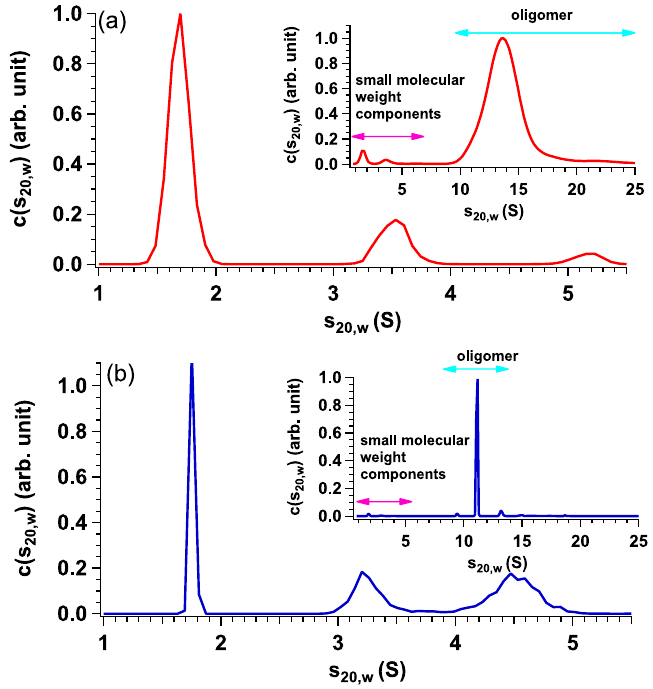
Figure 3. AUC spectra of dilute and dense samples. ( a ) c ( s 20,w ) from αB-crystallin in solution at 0.45 mg/mL measured at 60,000 rpm at 37 °C. The M w s of three peaks correspond to 19 kDa, 56 kDa and 101 kDa from the low c ( s 20,w ) to the high one, respectively. The inset shows c ( s 20,w ) from αB-crystallin in the solution at 0.45 mg/ mL measured at 40,000 rpm at 37 °C. The pink and light blue arrows indicate the region corresponding to small molecular weight components and oligomers, respectively. ( b ) c ( s 20,w ) from αB-crystallin in solution at 28.5 mg/ mL measured at 60,000 rpm at 37 °C. M w s of three peaks correspond to 21 kDa, 53 kDa, and 87 kDa from the low c ( s 20,w ) to the high one, respectively. The inset shows c ( s 20,w ) from αB-crystallin in the solution at 28.5 mg/ mL measured at 40,000 rpm at 37 °C. The pink and light blue arrows indicate the region corresponding to small molecular weight components and oligomers, respectively. This figure is prepared by the usage of IGOR Pro 6.34A (https ://www.wavem etric s.com/forum /news-and-annou nceme nts/igor-634a-now-shipp ing).